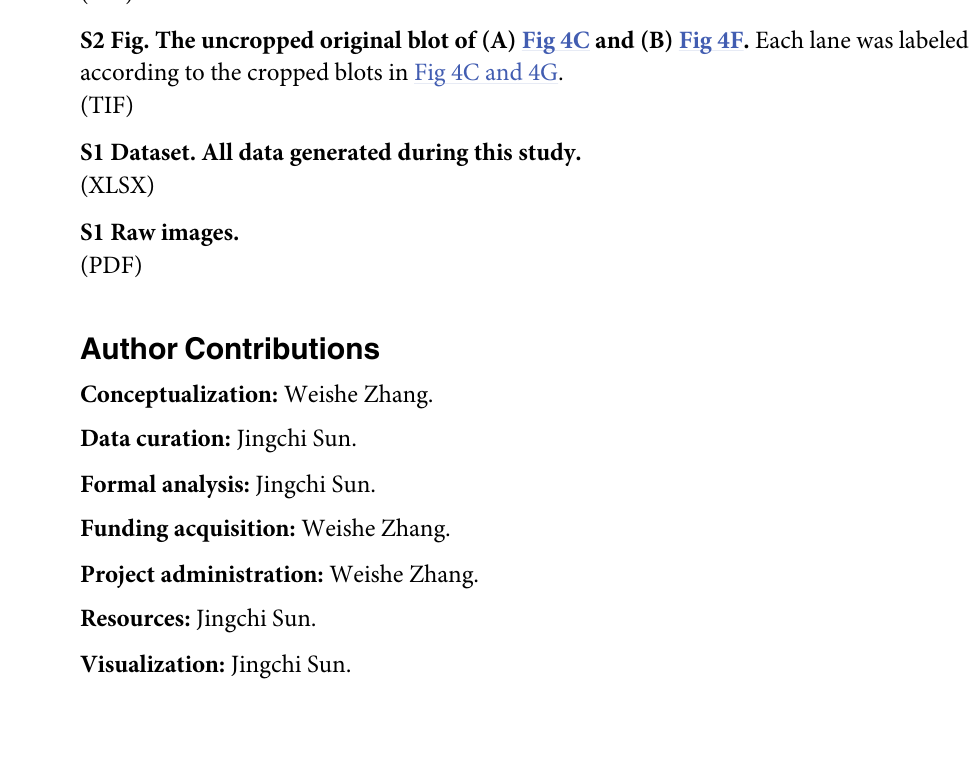
S1 Fig. Experimental design of protocols 1 and 2. S2 Fig. The uncropped original blot of (A) Fig 4C and (B) Fig 4F. Each lane was labeled according to the cropped blots in Fig 4C and